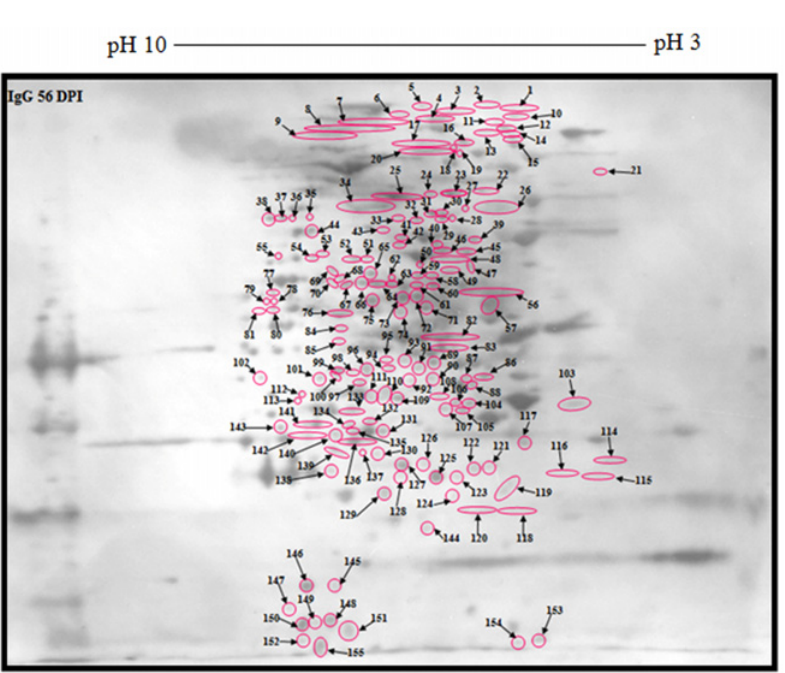
Fig 5. Immunoblot picture of unique reactive polypeptide spots of 2-DE separated T . gondii strain RH tachyzoite proteins using antibodies specific for IgG 56